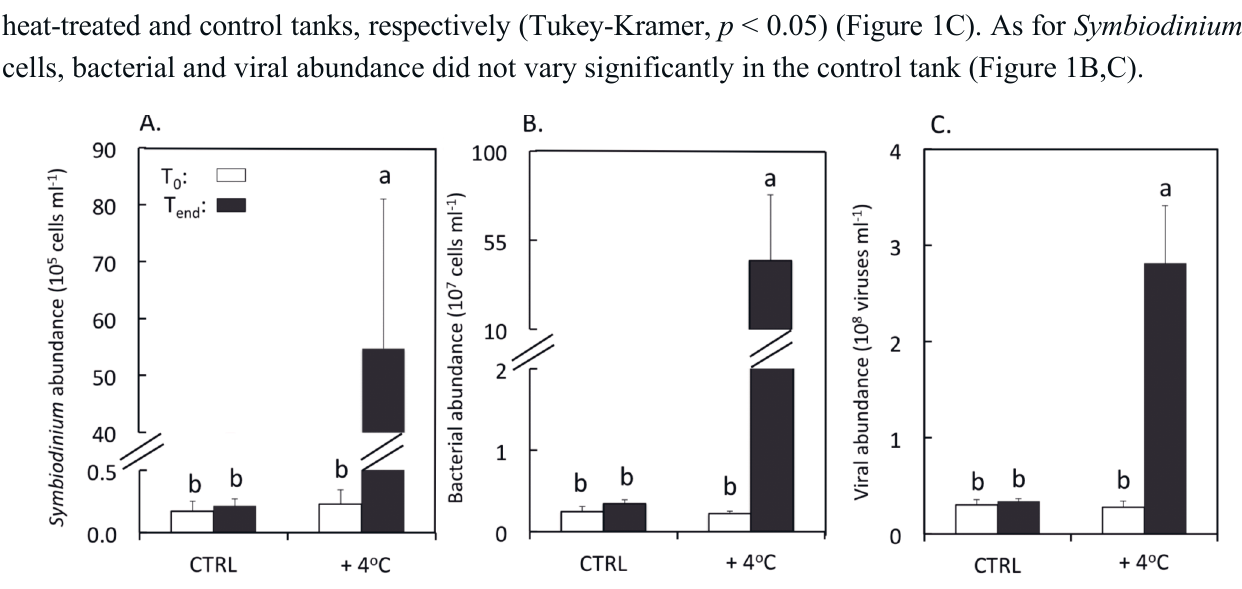
Figure 1. Abundances of Symbiodinium ( A ); bacteria ( B ), and viruses ( C ) in mucus samples of F. repanda in both control (CTRL) and heat-treatment (+4 °C) at the beginning ( T o ) and at the end of the experiment ( T end ). Error bars represent one standard deviation from the mean ( n = 3).Histograms with the same letters are not significantly different at p = 0.05.